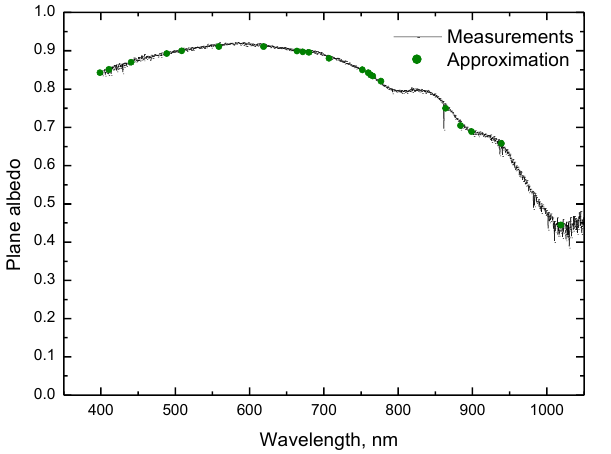
Figure 2. The derived spectral probability of photon absorption for the case presented in Fig.